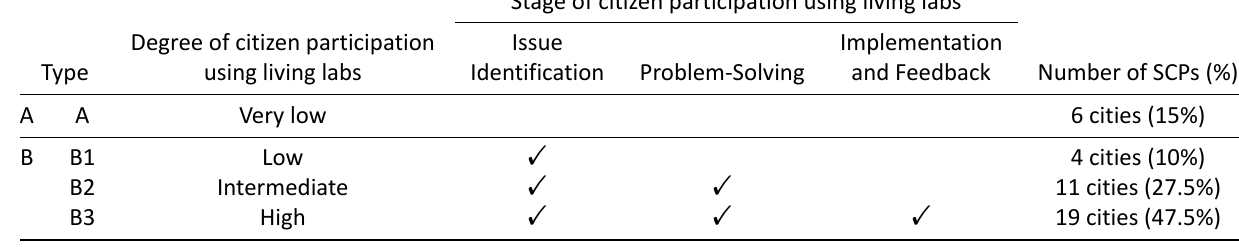
Table 1. Type of living